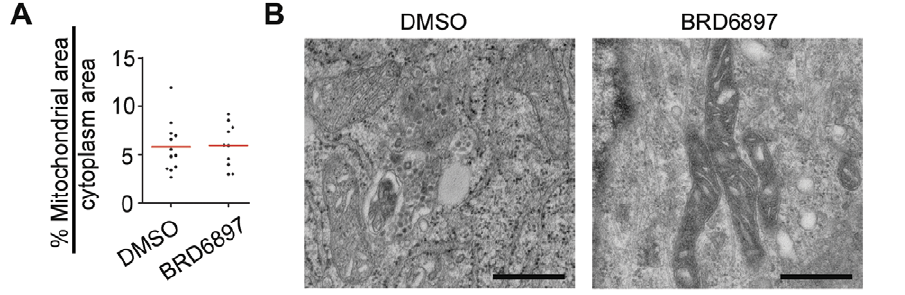
Figure 4. Changes in mitochondrial ultrastructure upon 3-day 10 m M BRD6897 treatment. ( A ) Plot of % cytoplasmic area occupied by mitochondria based on 10 replicate electron microscopy (EM) images per treatment. ( B ) Representative EM images of DMSO- and BRD6897-treated HUVEC. Scale bar: 500 nm.